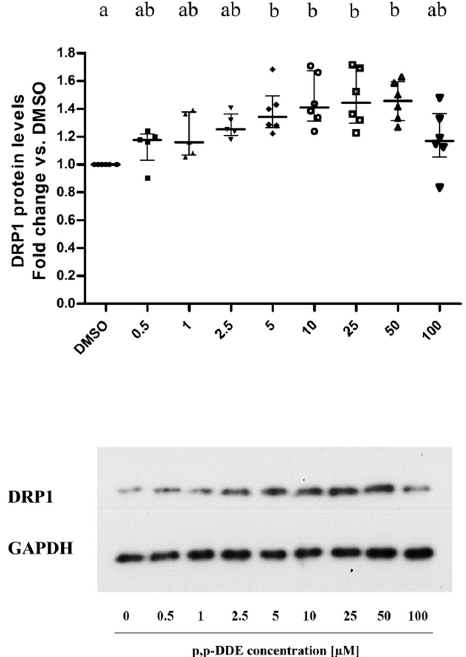
Figure 6. Mitochondrial fusion protein content. Mfn2 ( A ) and Opa1 (B ) protein content were analyzed by western blotting. All data were presented as median with interquartile of range for 6 or 7 (Mfn2) and 5 (Opa1) biological replicates. Representative images of both Mfn2 ( A ) and Opa1 ( B ) (above) and the relative loading control for protein normalization GAPDH (below). Statistical analyses were performed using GraphPad Prism software. One-way ANOVA analysis followed by Bonferroni’s post-hoc test: different letters indicate statistically different values.